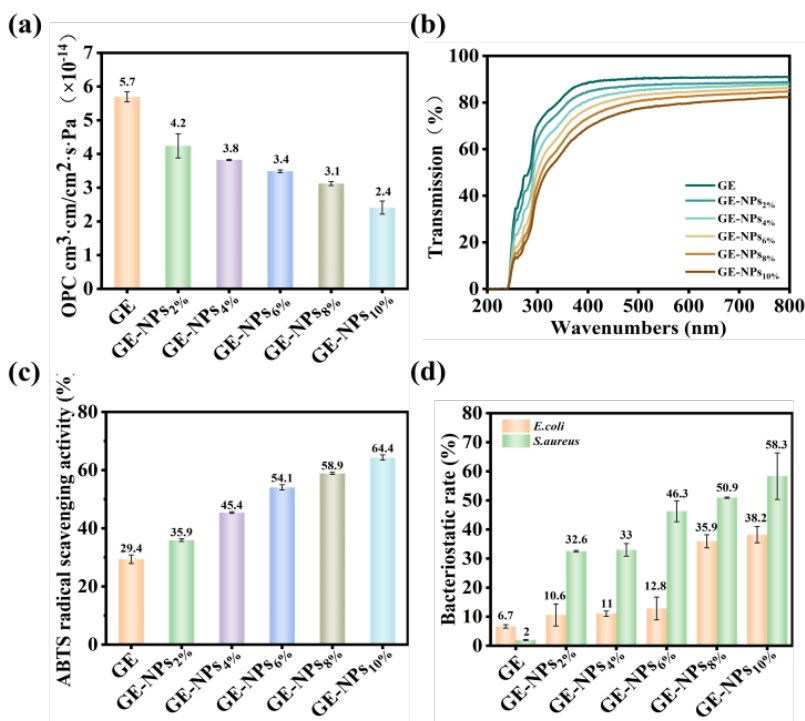
Figure 3. ( a ) OPC of GE coatings with different concentrations of NPs; ( b ) Light transmittance of GE coatings with different concentrations of NPs; ( c ) ABTS free radical scavenging rate of GE coatings with different concentrations of NPs; ( d ) Bacteriostatic rate of GE coatings with different bacteriostatic rate.